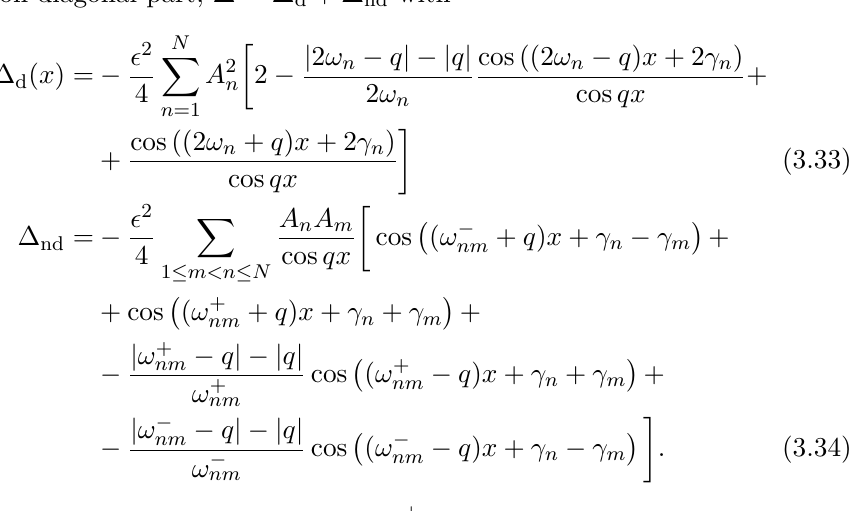
JHEP03(2018)187